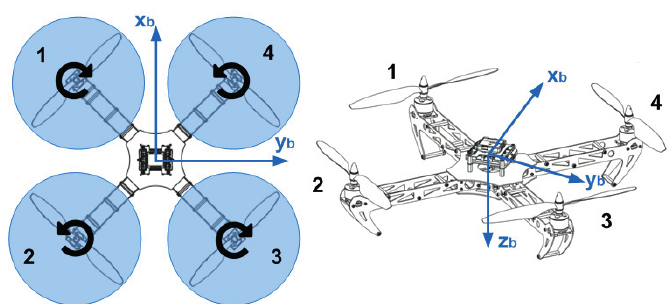
Figure 3. Structure and configuration of the quadrotor